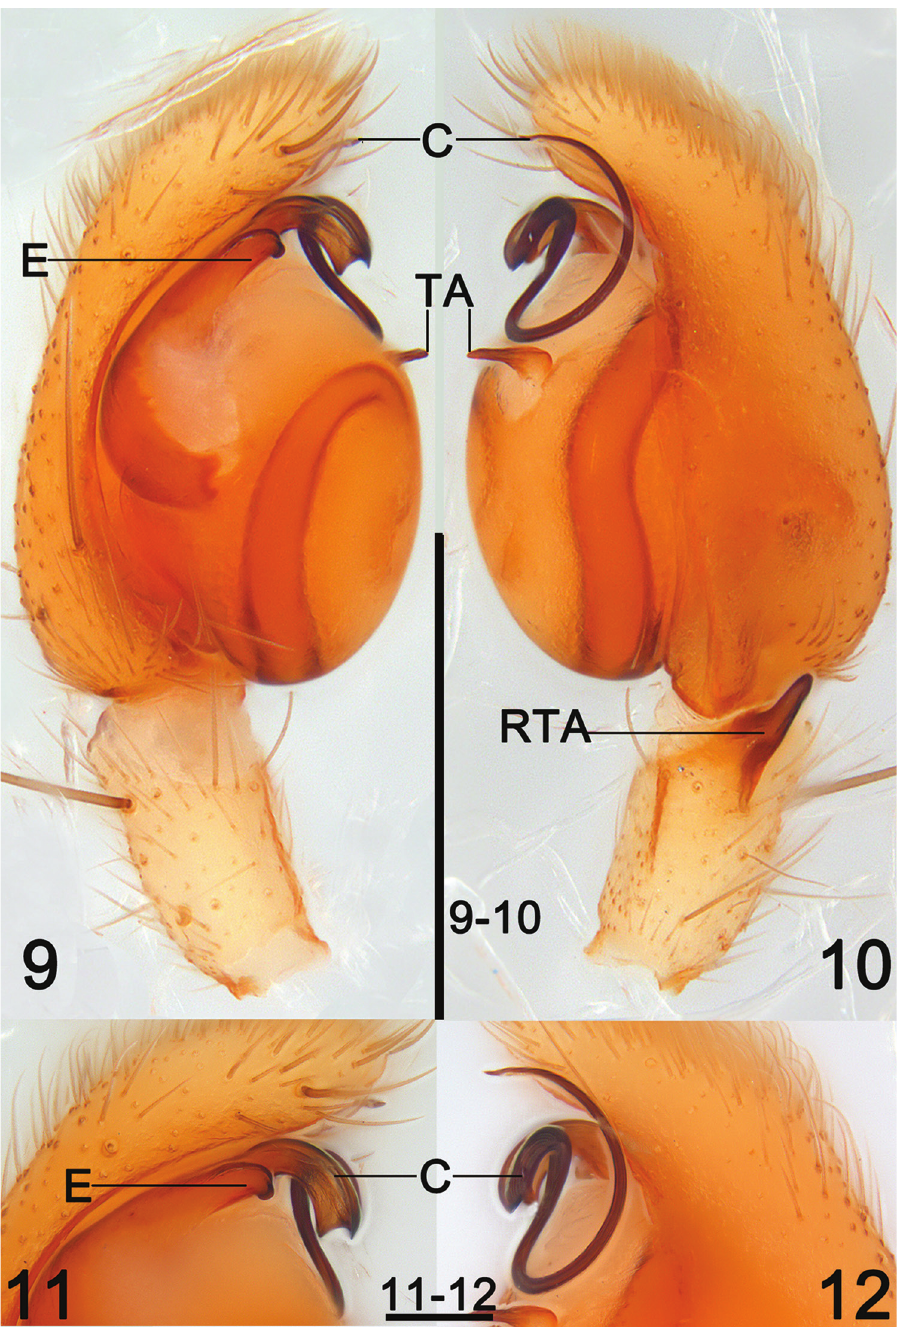
Figures 9–12. Clubiona filicata O. Pickard-Cambridge, 1874, male from Guangxi, China. 9 left palp, prolateral view 10 same, retrolateral view 11 apical appendage of tegulum, prolateral view 12 same, ret- rolateral view. Scale bars 0.5 mm ( 9–10 ); 0.1 mm ( 11–12